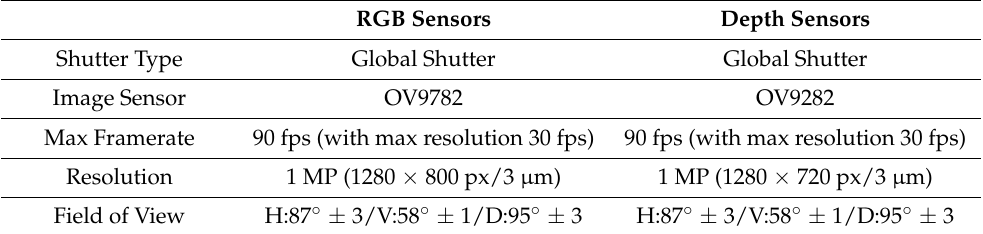
Table 1. Sensor specifications of the Intel RealSense D455